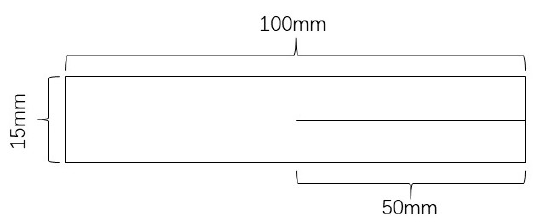
Figure 1. The size of the sample for the tensile strength test.